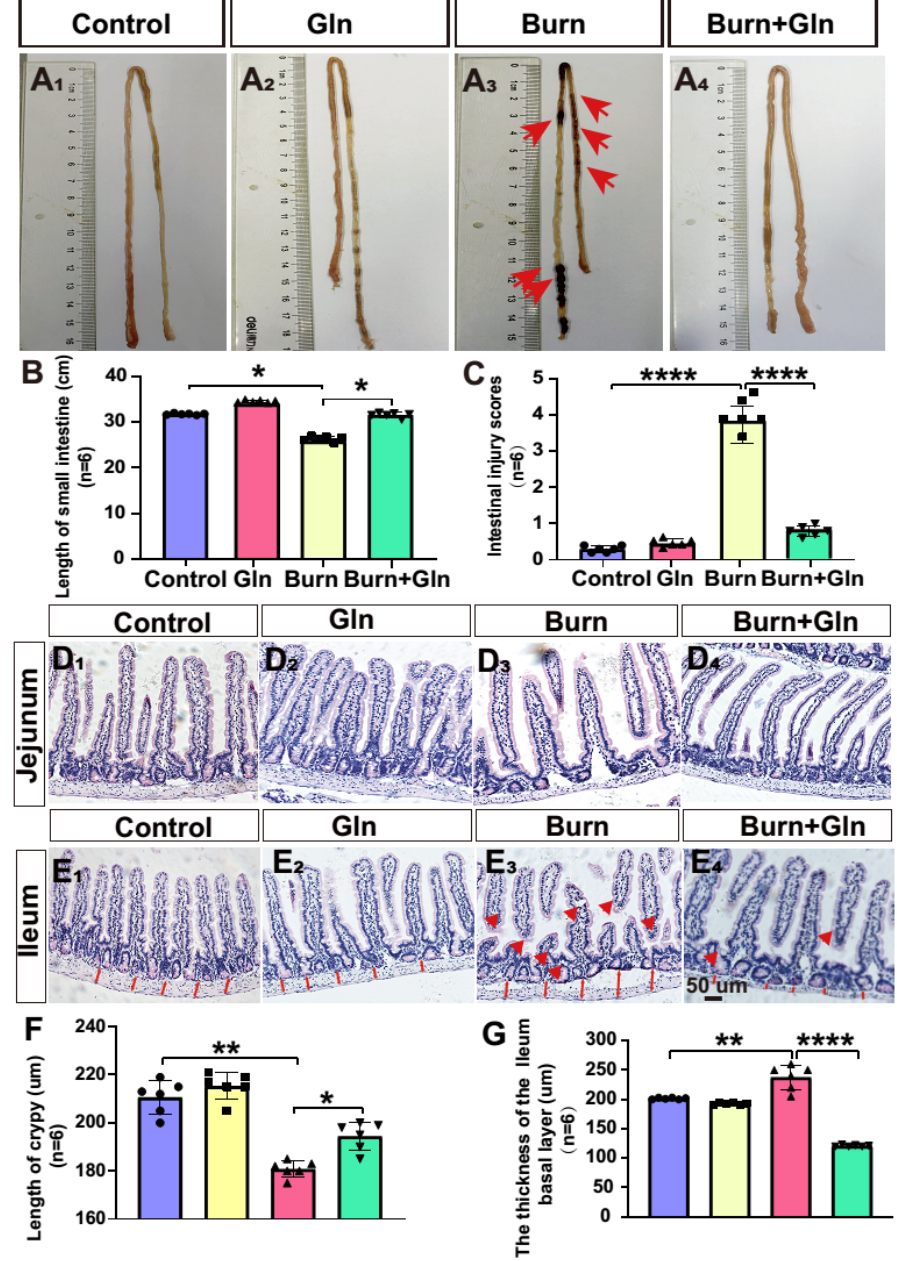
Figure 1. Effect of burn injury on the pathological structure of small intestinal crypts. The villus length and crypt depth were measured as indicated in the image ( × 100; n = 6). Yellow arrows indicate goblet cell in fi ltration in the small intestine. The red bidirectional arrows indicate the thickness of the basal tissue of the small intestinal crypt. ( A 1 – A 4 ) Representative images of the small intestine of each group under a light microscope: ( A 1 ) Control group; ( A 2 ) Burn group; ( A 3 ) Gln group; and ( A 4 ) Burn+Gln group. ( B ) Quantitative analysis of the length of the small intestine under di ff erent treat- ments. ( C ) Quantitative analysis of the number of preservation injury scores of the small intestine of di ff erent groups. ( D 1 – D 4 ) Representative images of the hematoxylin and eosin (H&E) staining of the small intestine sections in jejunum from control\Gln\Burn and Burn+Gln group at day 3. ( E 1 – E 4 ) Representative images of H&E staining of the small intestine sections in ileum from con- trol\Gln\Burn and Burn+Gln group at day 3. ( F ) The statistical analysis of the length of crypts from images shown in ( E 1 – E 4 ). ( G ) The statistical analysis of the thickness of the lleum basal layer in ileum